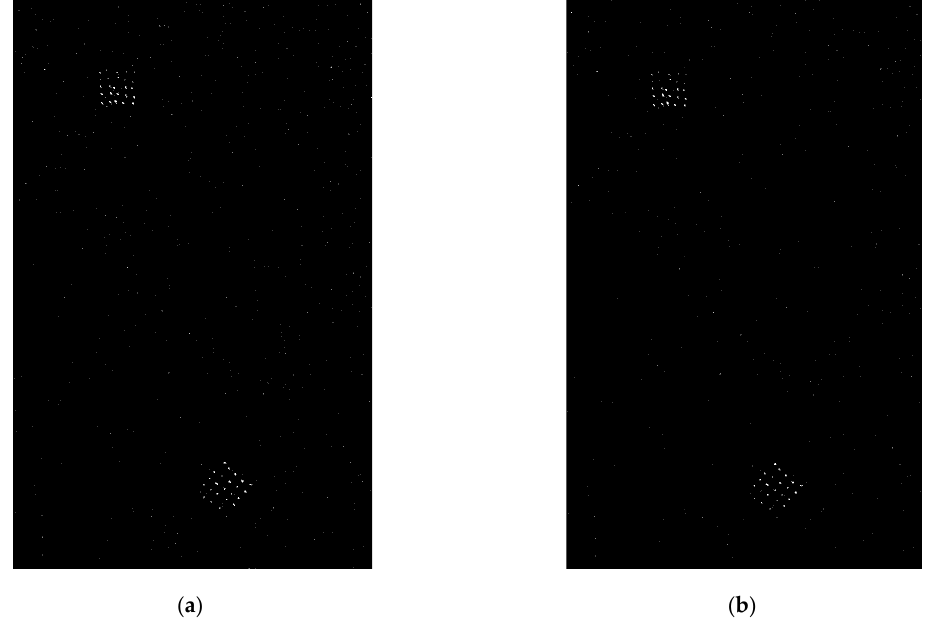
Figure7. CFAR detection results for the image pair shown in Figure3: ( a ) detection results based on GG model; ( b ) detection results based on proposed model. GG model; ( b ) detection results based on proposed model.